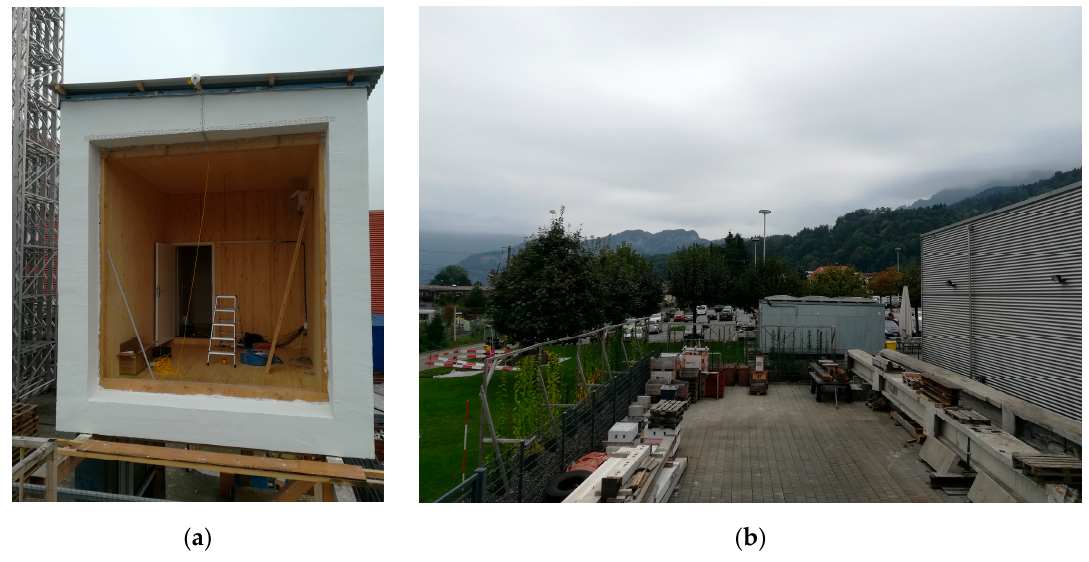
Figure 1. ( a ) Front view of the test cell opening (under construction) and ( b ) outlook.